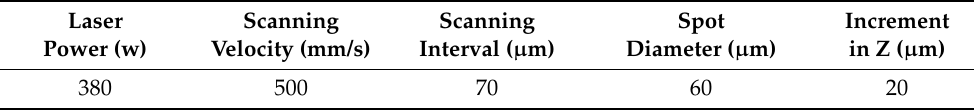
Table 2. SLM process parameters used for specimen